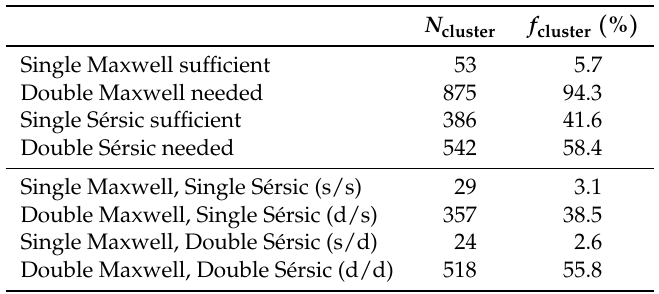
Table 2. Relative fractions of the 928 clusters and groups with regard to their Maxwell- and Sérsic-fit